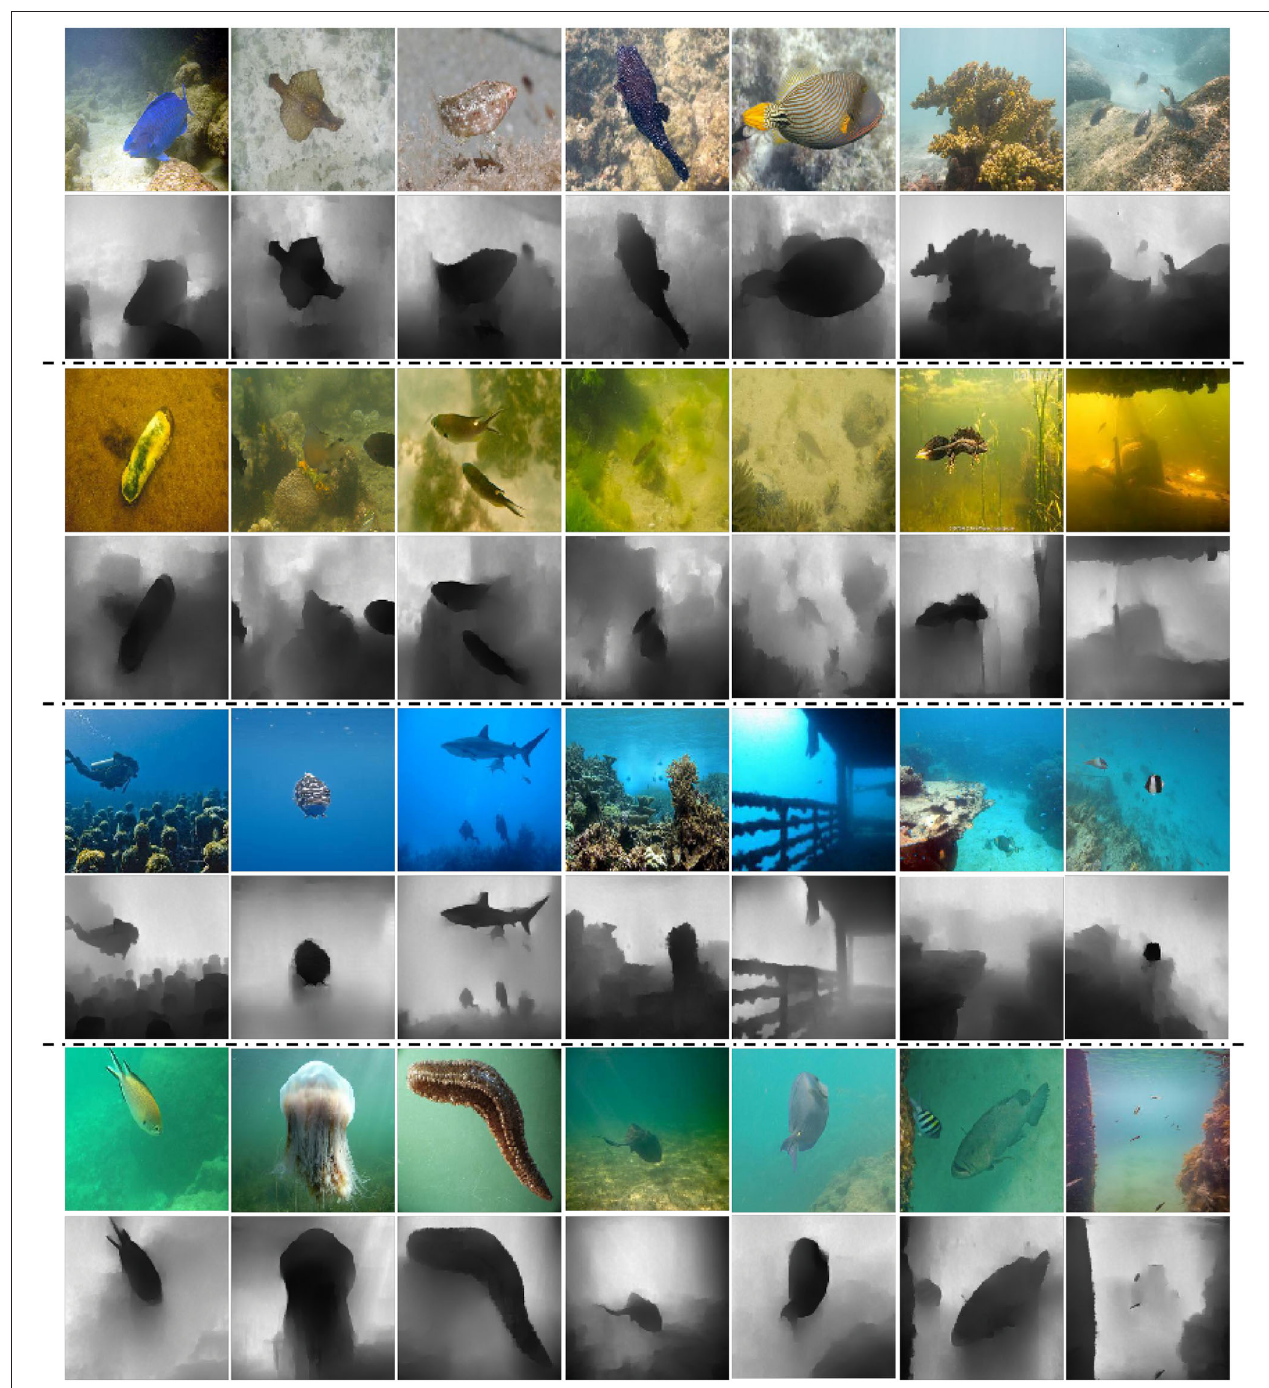
FIGURE 9 | Multi-style underwater depth map estimation. The rows from top to bottom are real underwater images with four different water types and the results of our model for depth map estimation. Every two rows are real underwater images and their predicted depth maps of our method.